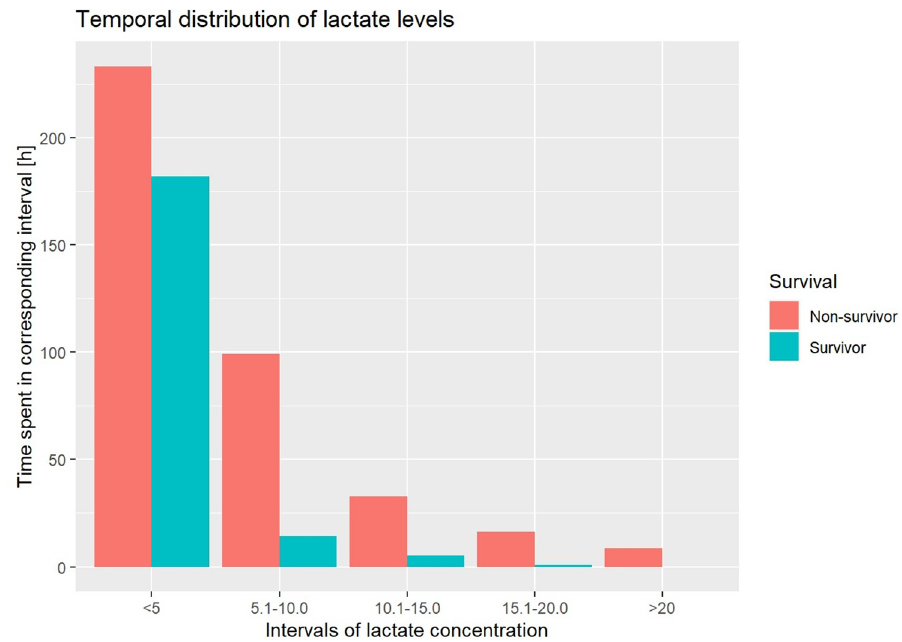
Fig 3. Temporal distribution of lactate